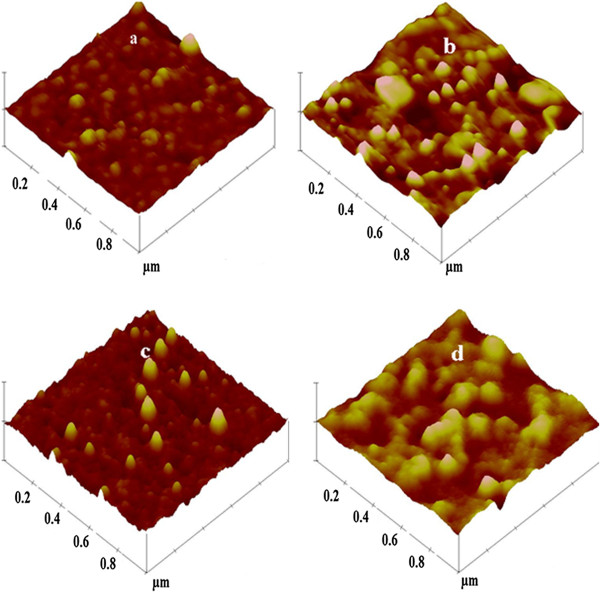
AFM images of (a, b) 5:10- and (c, d) 5:5-nm Al2O3/ZrO2films. (a, c) As-deposited. (b, d) After annealing.